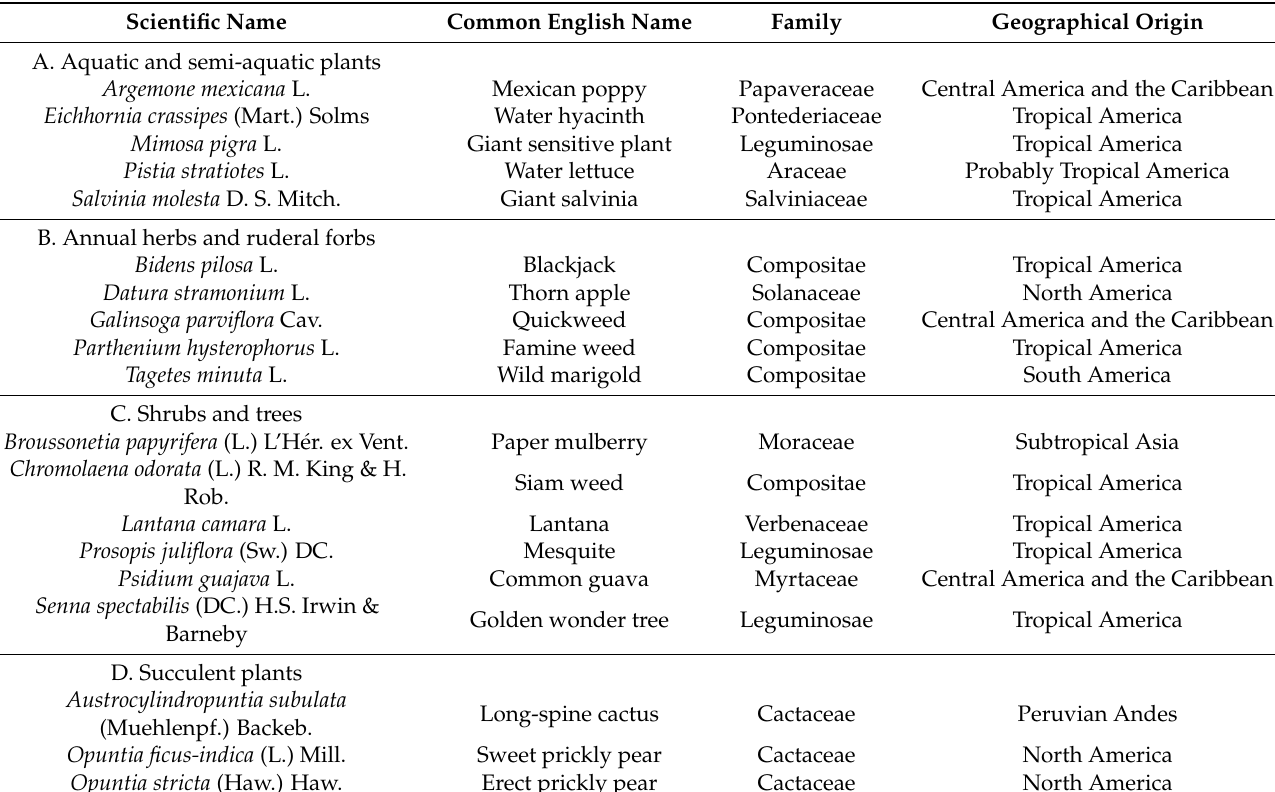
Table 1. Vascular plant species cited in this article as invasive for African countries and grouped according to their life